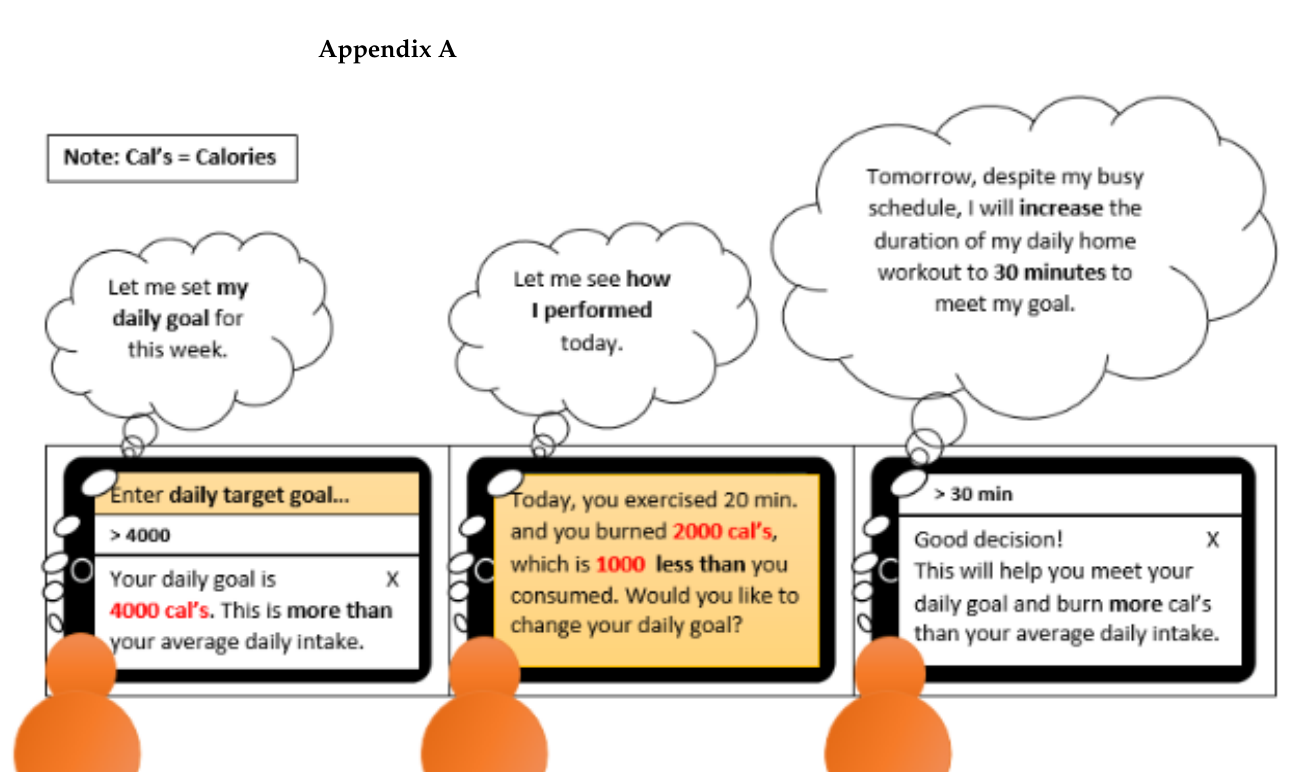
Figure A1. Low-fidelity storyboard illustrating the Goal-Setting/Self-Monitoring feature of the fitness app [30].